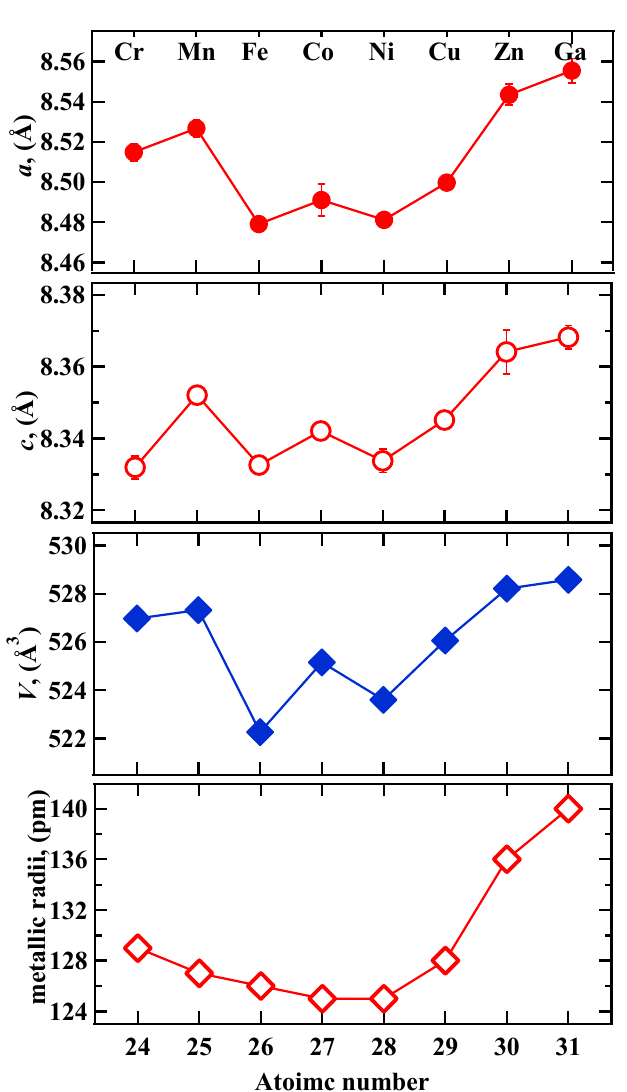
Figure 1. ( a ) XRD powder profile for Gd 2 Fe 17 and Gd 2 Fe 16 Ga 0.5 TM 0.5 (TM = Cr, Mn, Co, Ni, Cu, Zn, and Ga). ( b ) Rietveld refined XRD data of Gd 2 Fe 17 and Gd 2 Fe 16 Ga 0.5 TM 0.5 (TM = Cr, Mn, Co, Ni, Cu, Zn, and Ga).